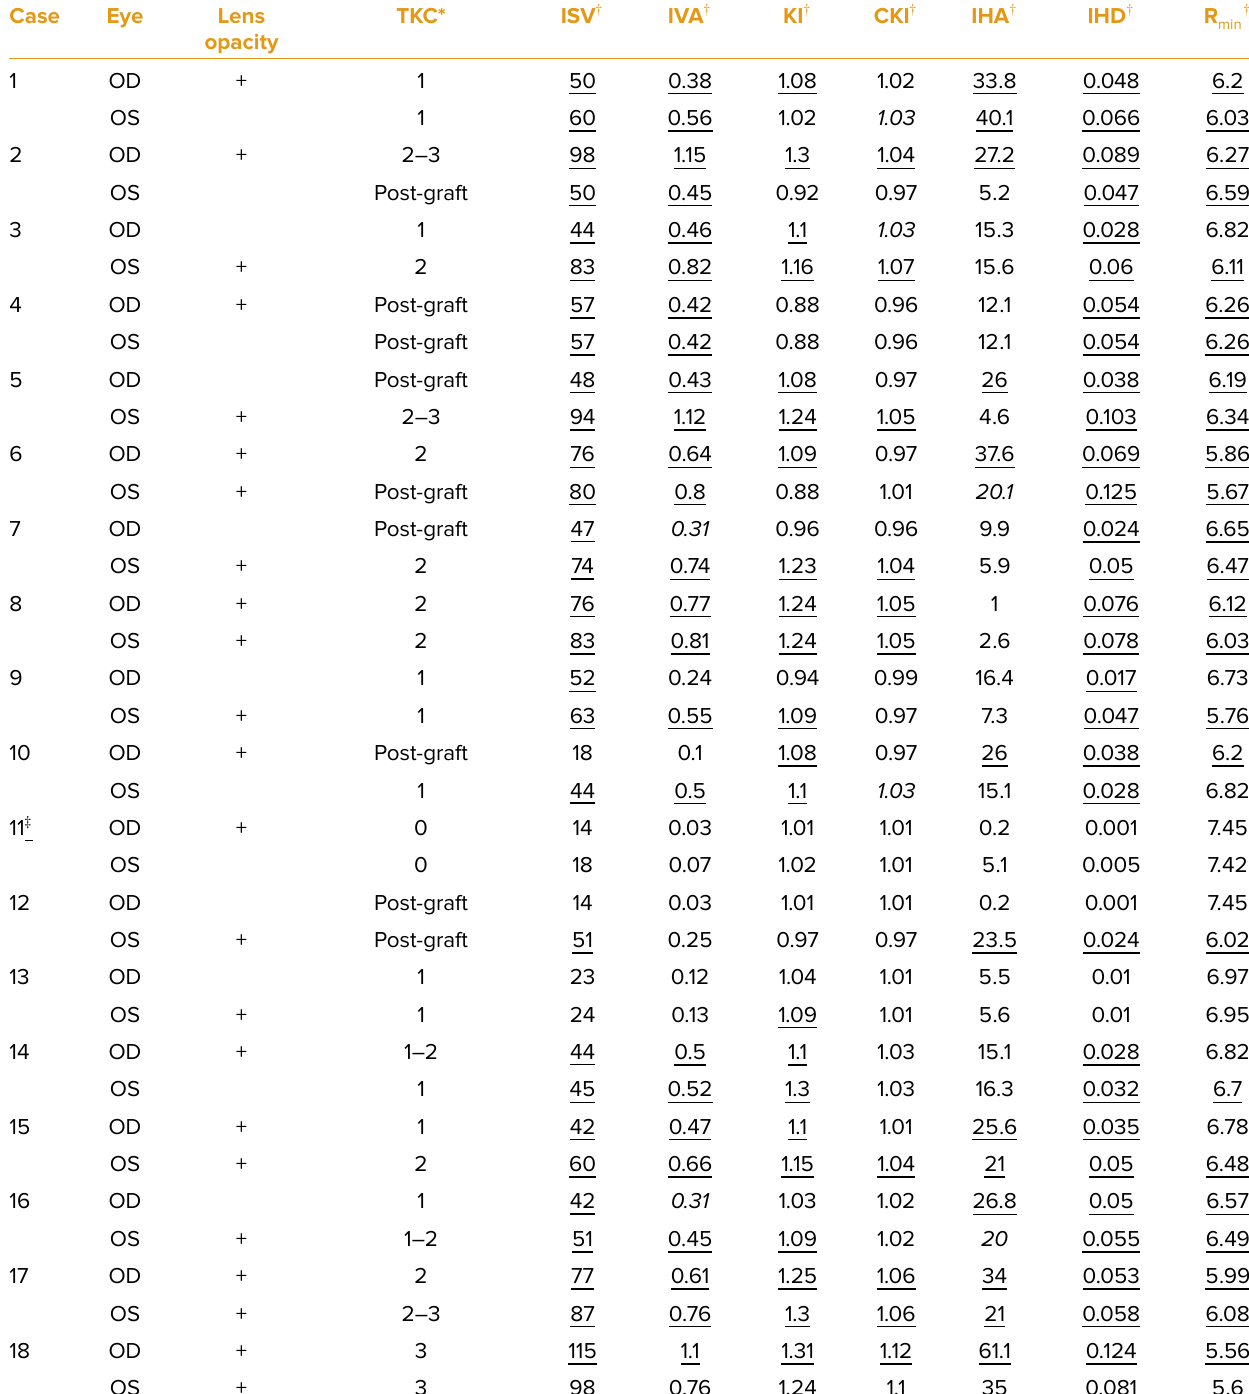
Table 2. Pentacam keratoconus indices and feather-shape lens opacity in reported cases